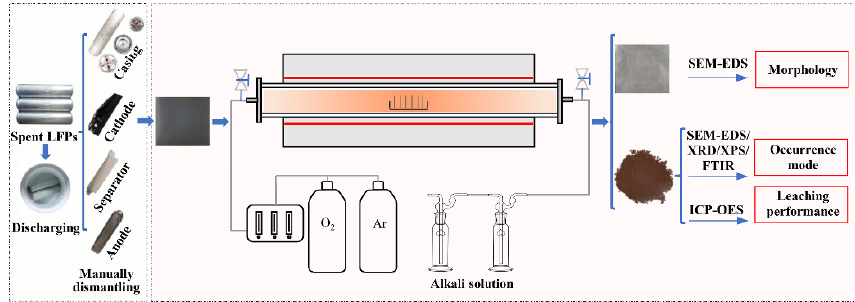
Figure 1. Flowsheet of the experimental process for the recovery of spent LFPBs cathode plates.